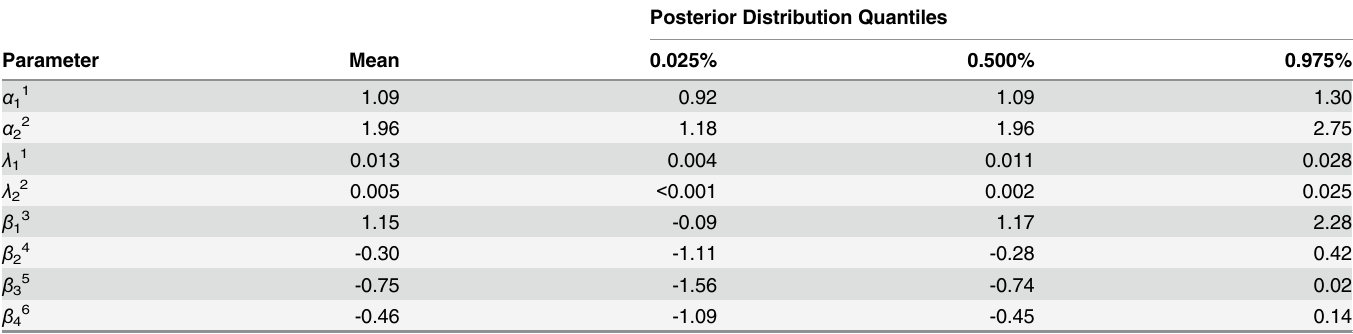
Table 2. Estimates of hazard model parameters for uninfected and CWD infected